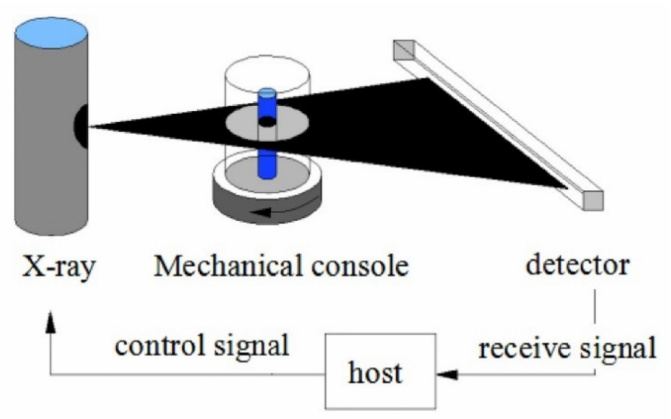
Figure 21. Schematic of X-ray µ CT